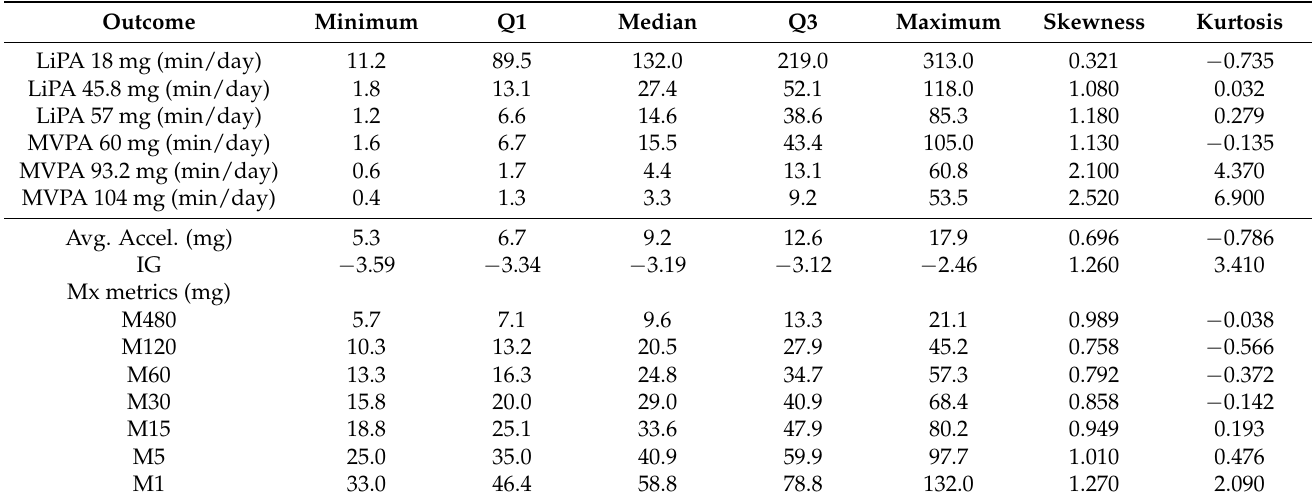
Table 3. Descriptive results of physical activity in centenarians.